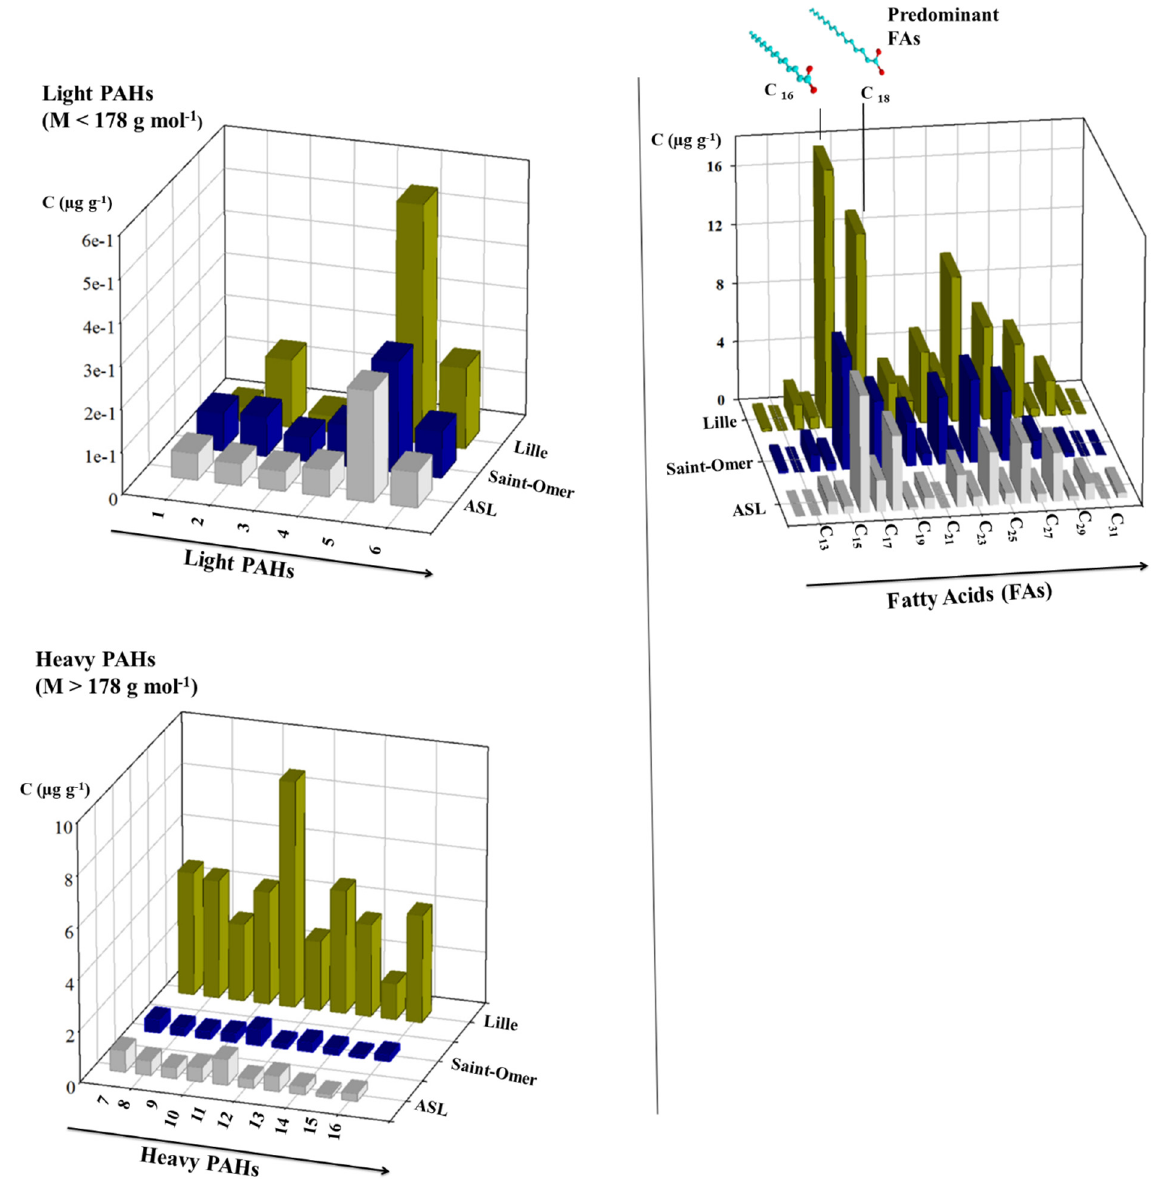
Figure 3. Fatty Acids (FAs) and Polycyclic Aromatic Hydrocarbons (PAHs) distribution within the raw sediments of Lille, Saint Omer and ASL. PAHs assignations: 1 Naphthalene; 2 Acenaphthylene; 3 Acenaphthene; 4 Fluorene; 5 Phenanthrene; 6 Anthracene; 7 Fluoranthene; 8 Pyrene; 9 Benzo (a) anthracene; 10 Chrysene; 11 Benzo (b) fluoranthene; 12 Benzo (k) fluoranthene; 13 Benzo (a) pyrene; 14 Indeno (1,2,3-cd) pyrene; 15 Dibenzo (a,h) anthracene; 16 Benzo (g,h,i) perylene.